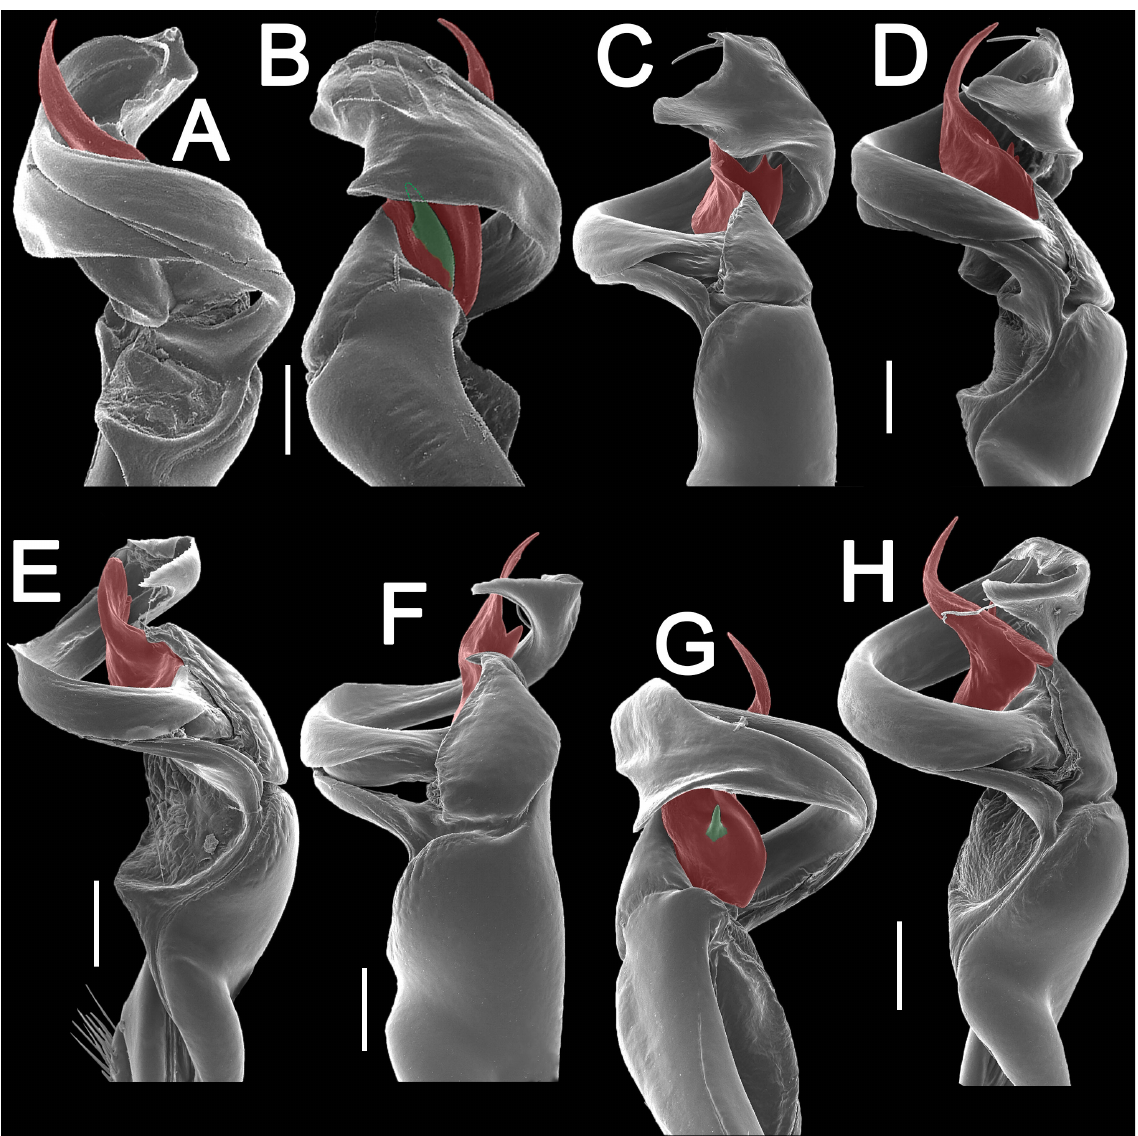
Fig. 15. Tylopus acuminatus sp. nov., paratype, ♂, from Phufa ( A–B ), paratype, ♂, from Phuthalang forest protected area ( C–D ), paratype, ♂, from forest near road ( E ), paratype, ♂, from Ban Na Thong ( F ), paratype, ♂, from Phagneung Phoukulom waterfall ( G–H ). A–H . Distal part, sublateral, submesal, dorsal, subdorsal, dorsal, subdorsal, ventral and dorsal views, respectively. Scale bars = 0.2 mm. red colour shows process h. Green colour shows spine